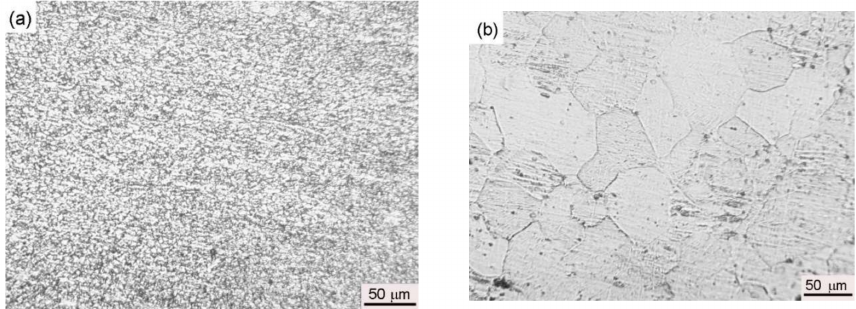
Figure 2. Optical microstructures of the base metals ( a ) Ti-6Al-4V and ( b )